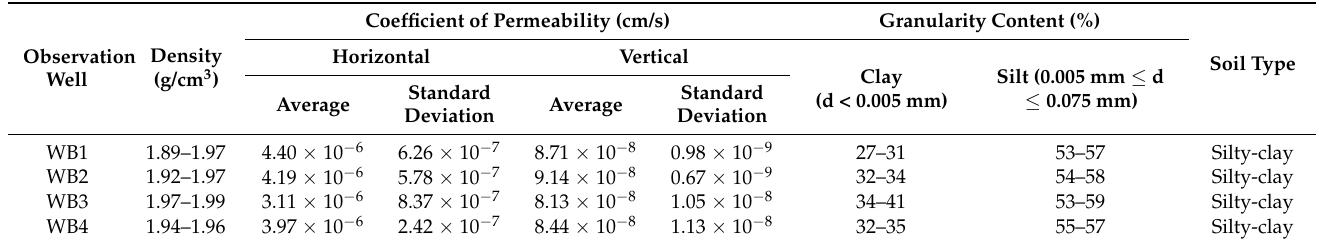
Table 2. Physical properties of the sediment in the riparian hyporheic